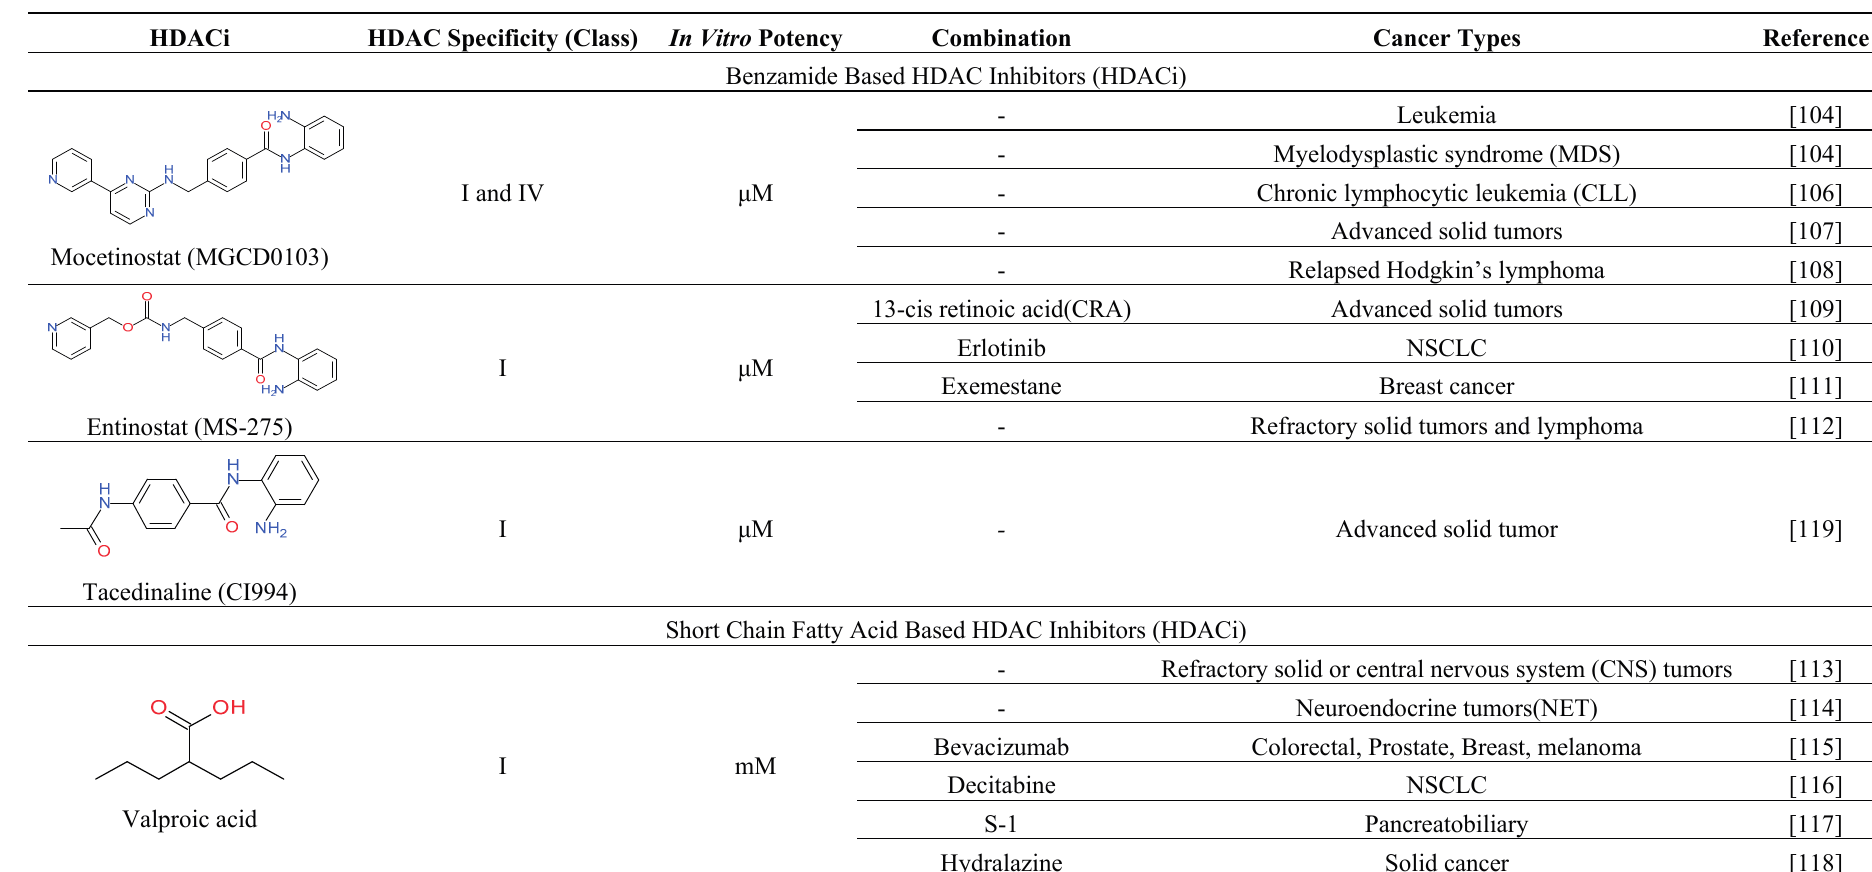
Table 3. Benzamide, short chain fatty acid and cyclic peptide based HDAC inhibitors in clinical